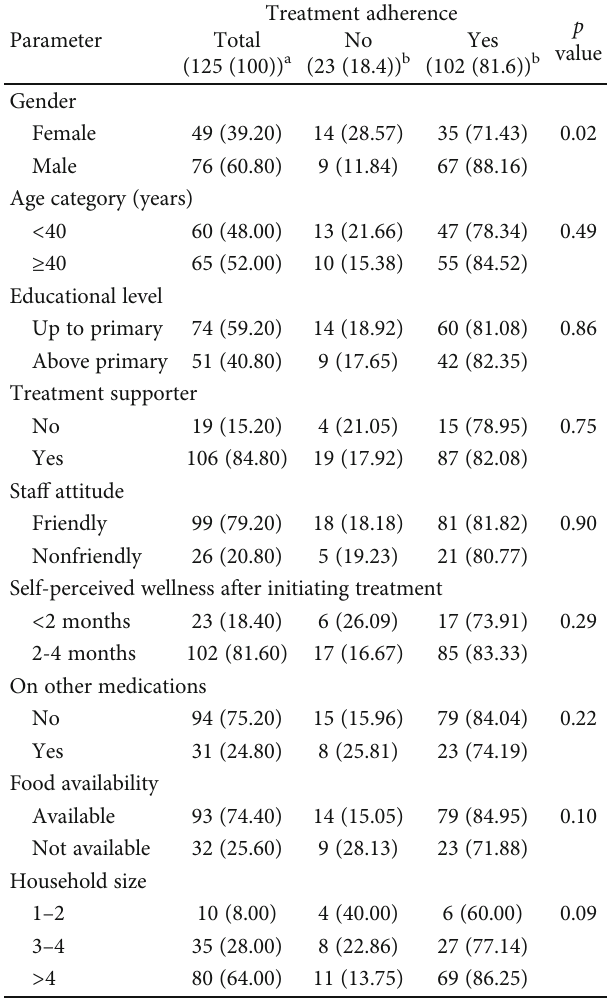
Table 2: Respondent ’ s knowledge of TB symptoms, transmission, and treatment duration.